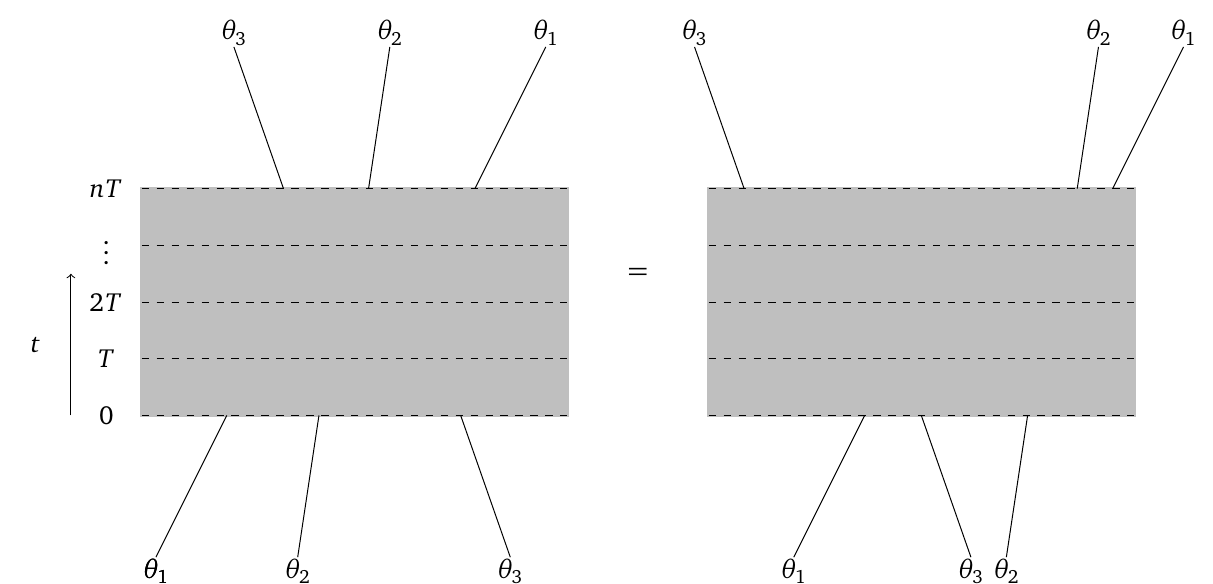
Figure 5: We picture schematically the stroboscopic evolution of particle trajectories with rapidities θ , after n full periods, under an integrable Floquet Hamiltonian. 1,2,3 The property of elasticity is displayed in the fact that after n full periods, the par- ticle content and set of rapidities is conserved. Note that there does not need to be elasticity at microscopic times within a single period. The property of factoriza- tion is displayed by the fact that the positions of particle trajectories can be shifted individually, but the amplitude for the two depicted processes must be